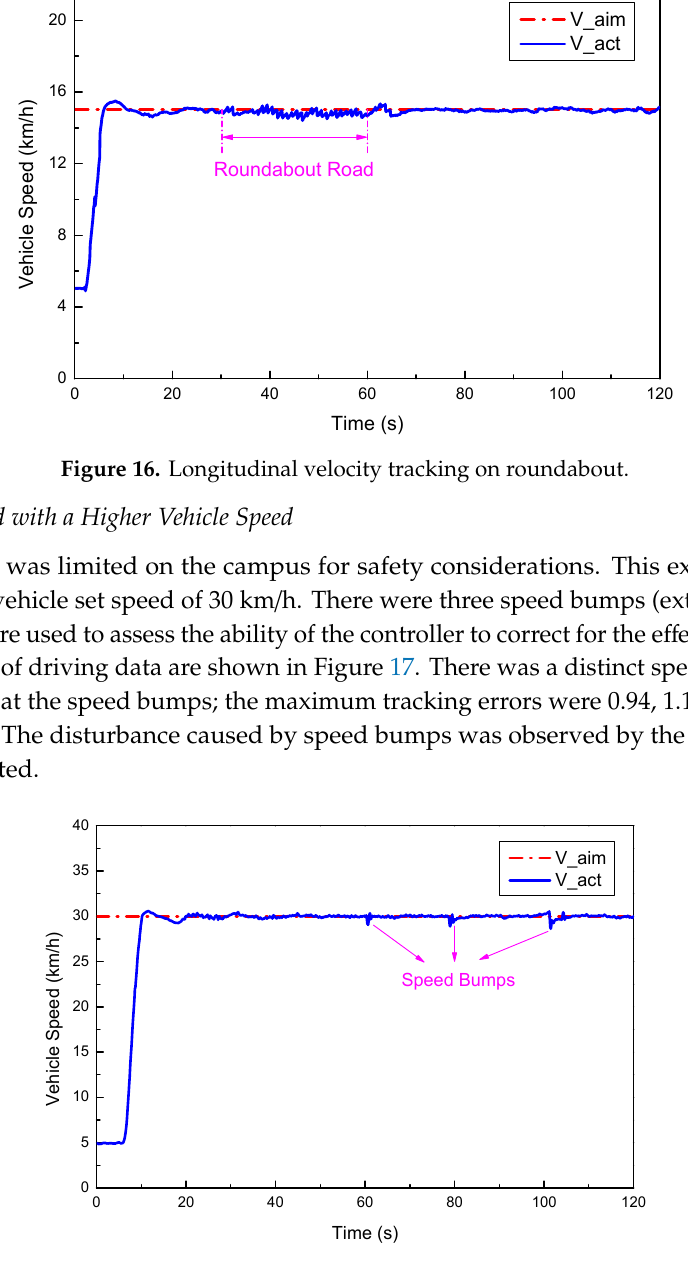
Figure 17. Longitudinal velocity tracking results at the set speed 30 km/h.